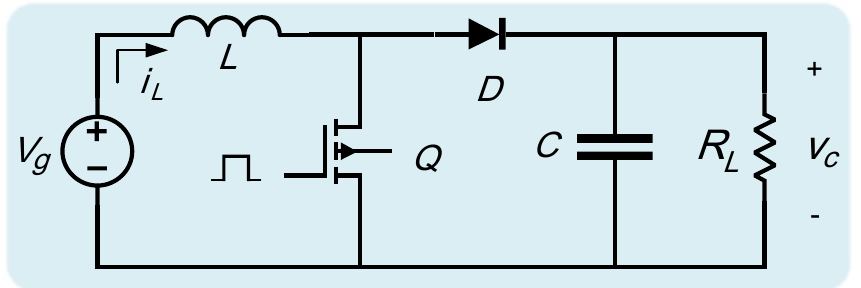
Figure 1. Electrical diagram of DC–DC boost